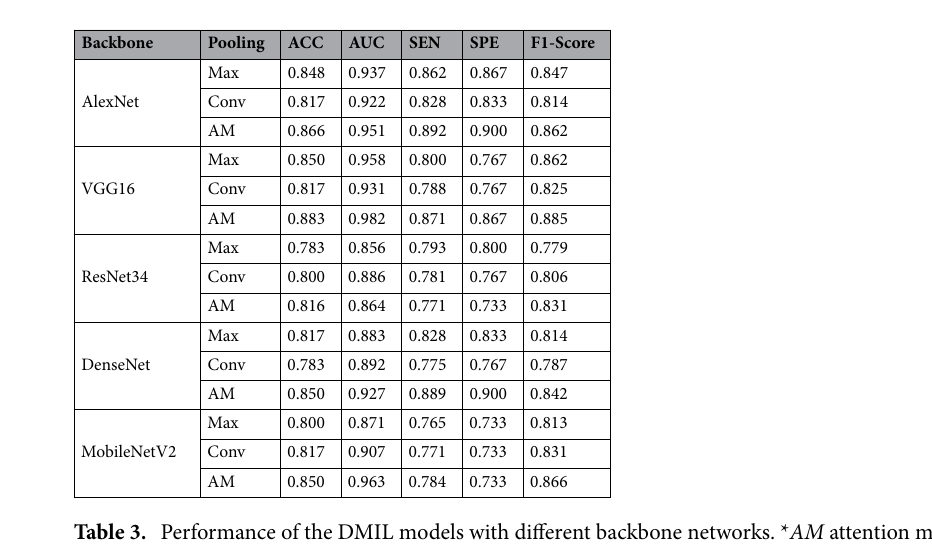
Table 3. Performance of the DMIL models with different backbone networks. * AM attention mechanism, ACC accuracy, AUC area under the curve, SEN sensitivity, SPE specificity.